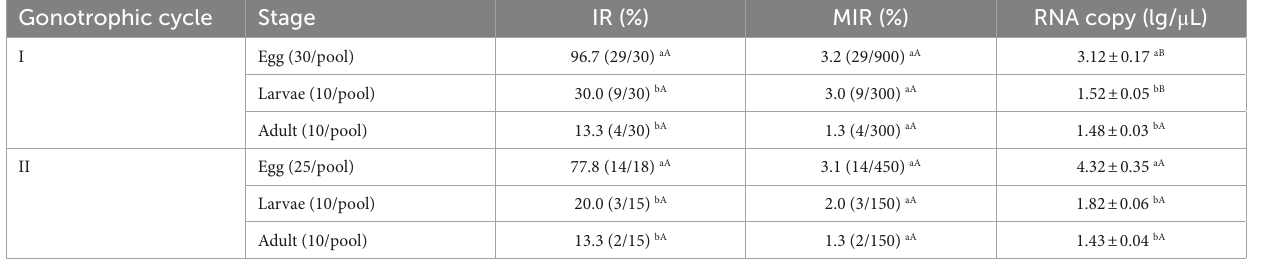
TABLE 1 TAHV PJ01 strain infection of F1 progeny of Aedes albopictus in the first and second gonotrophic cycle. Gonotrophic cycle Stage IR